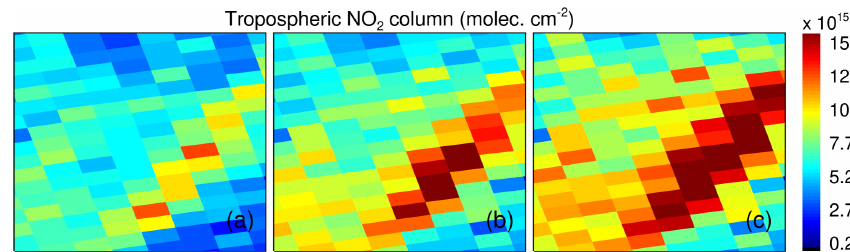
Figure 9. Similar to Fig. 7 but for tropospheric (trop.) NO 2 vertical column density.